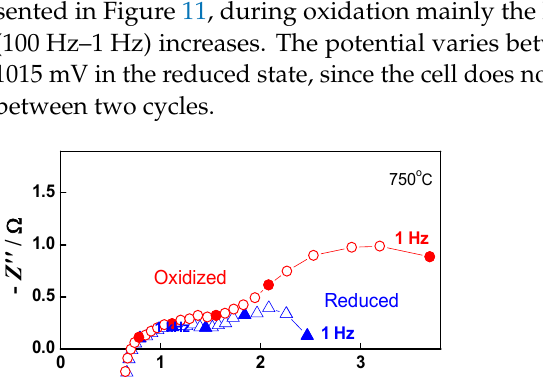
under loads of 0.10 Acm −2 , 0.28 A.cm −2 , and 0.5 A.cm −2 (Figure 12).